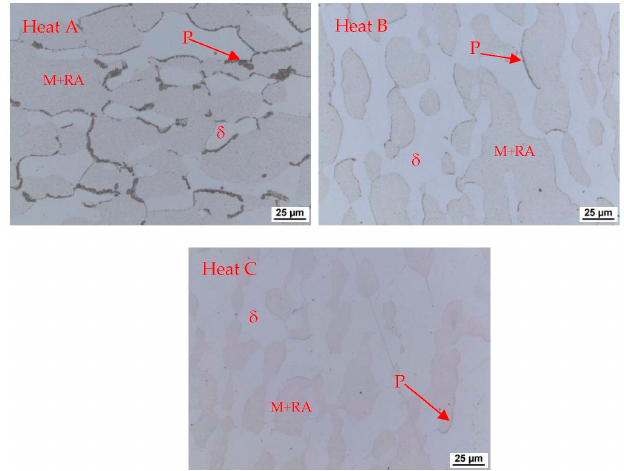
Figure 15. Pearlitic islands at the boundaries of the original austenitic grains formed during cooling at 50 °C s − 1 . P—pearlite, δ —ferrite, M—martensite, RA—retained austenite. X-ray diffraction was used (Figure 16) to evaluate the proportion of retained austen- ite (RA) in the dilatometric samples processed according to the curves in Figure 14. The amounts of RA in the structure for each heat are shown in Table 3.